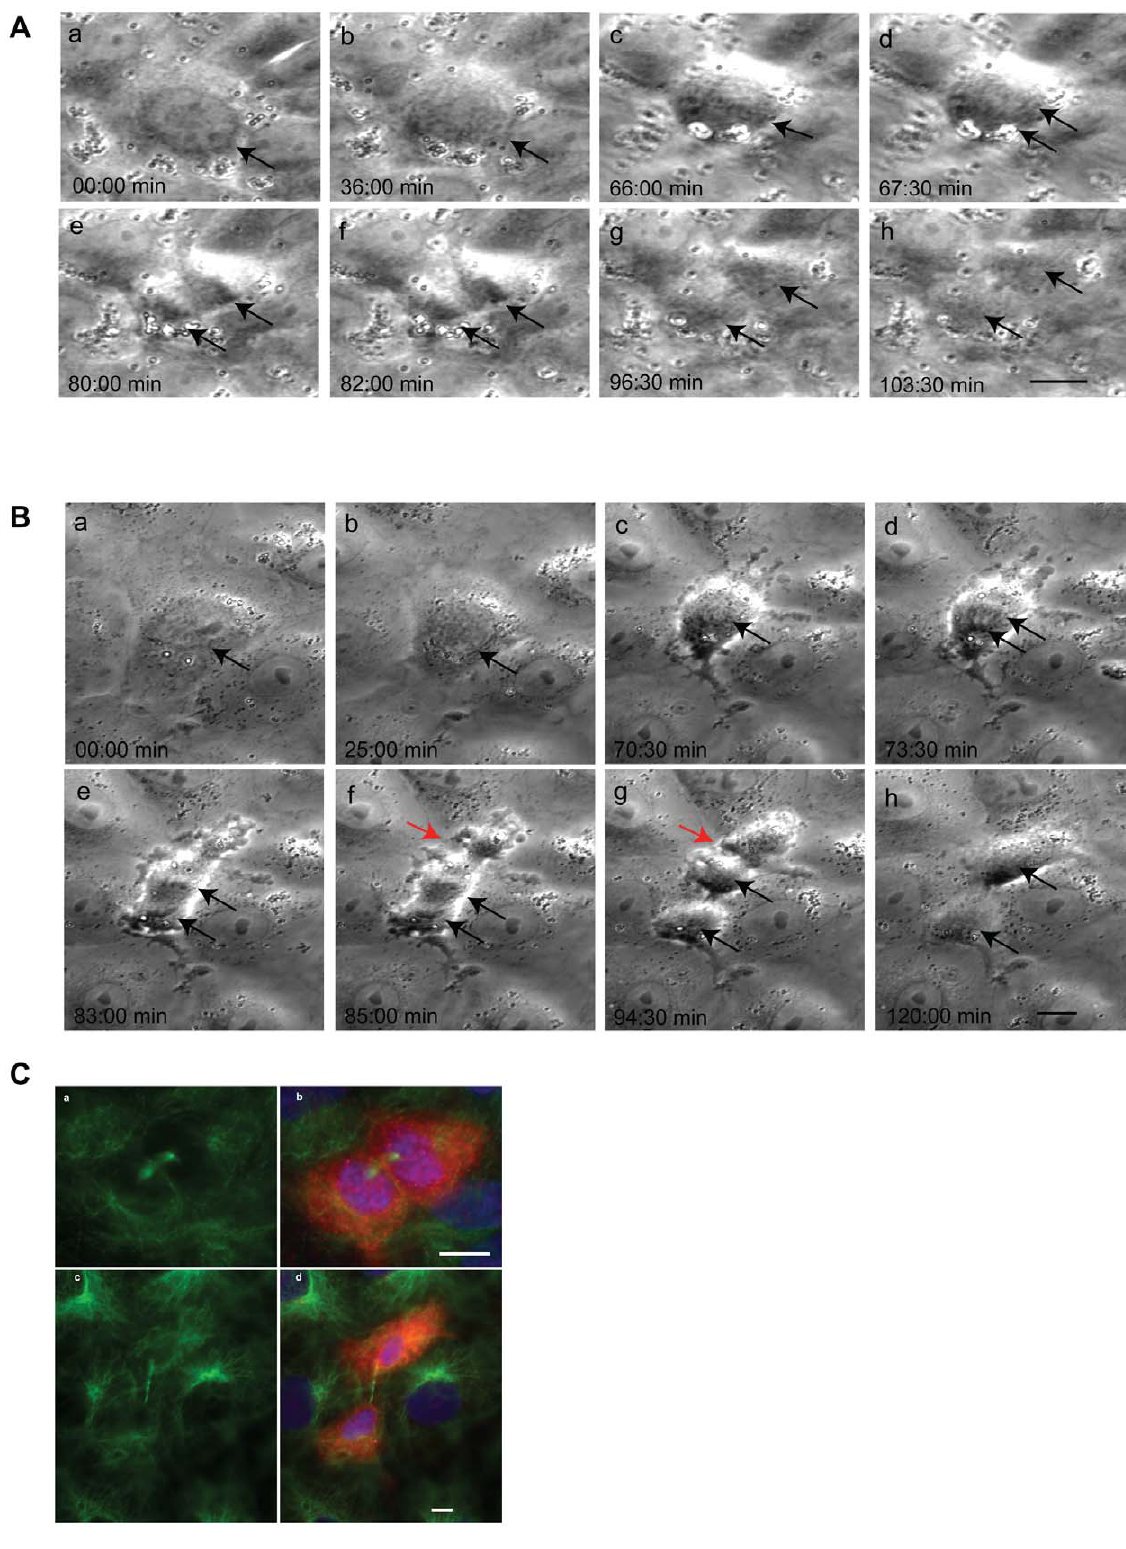
Figure 12. Microinjection of mitotic NRK-52E cells with GST or GST-EB1-C84 fusion protein. Stills from representative time-lapse movies of mitotic NRK-52E cells after microinjection with GST alone (A, a–h) or GST-EB1-C84 (B, a–h). Black arrows indicate the position of the chromosomes. Note cortical blebbing and the formation of an ectopic cleavage furrow, which is resolved by the time the GST-EB1-C84 injected cell reaches cytokinesis (B, red arrow) C: The cells shown in A and B were fixed and immunostained with an antibody specific for alpha-tubulin (green) and counterstained using DAPI (blue). Injected cells were identified by the presence of fluorescent dextran (red). The cells shown in a and b are daughter cells of the cell injected with GST, while the cells in c and d are daughter cells of the cell injected with GST-EB1-C84. Note the formation of uneven daughter cells after microinjection with the GST-EB1-C84 protein. Merged images are shown in b and d. Scale bars=10 and 5 m m. doi:10.1371/journal.pone.0028884.g012 PLoS ONE |